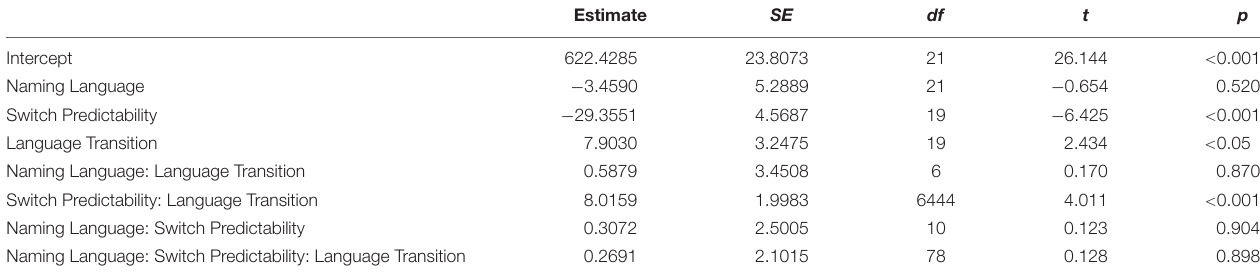
TABLE 1 | Results of LME on RT.